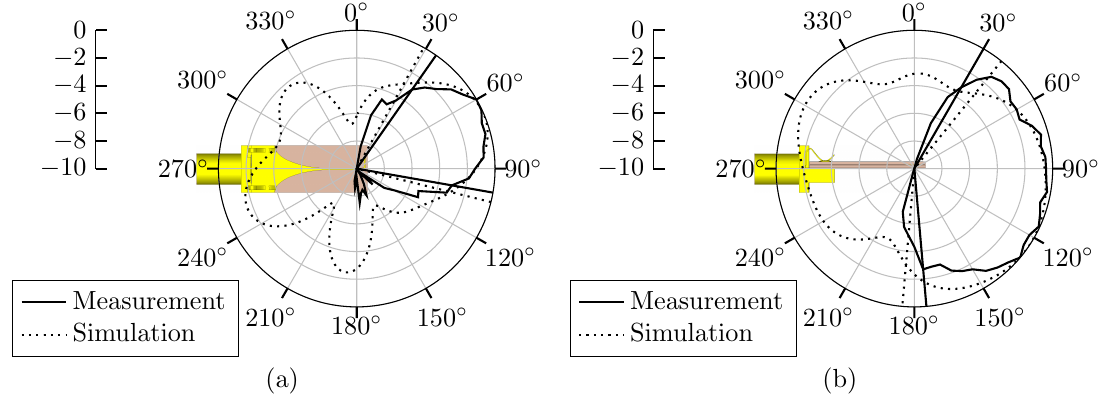
Figure 5. Simulated and measured far-field radiation pattern of the dipole antenna with split-ring = 10.41GHz. The field amplitudes are normalized to 0dB for comparison. resonator (SRR) at f SRR ( a ) Far-field in the E-plane. ( b ) Far-field in the